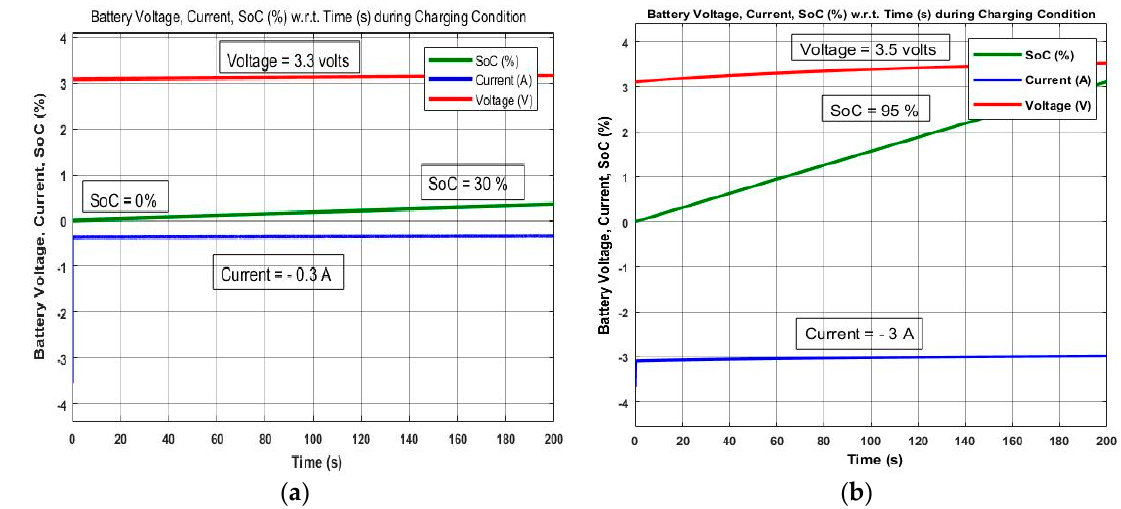
Figure 12. Simulation results of PWM controlled and P&O MPPT controlled solar SEH system for 200 s.